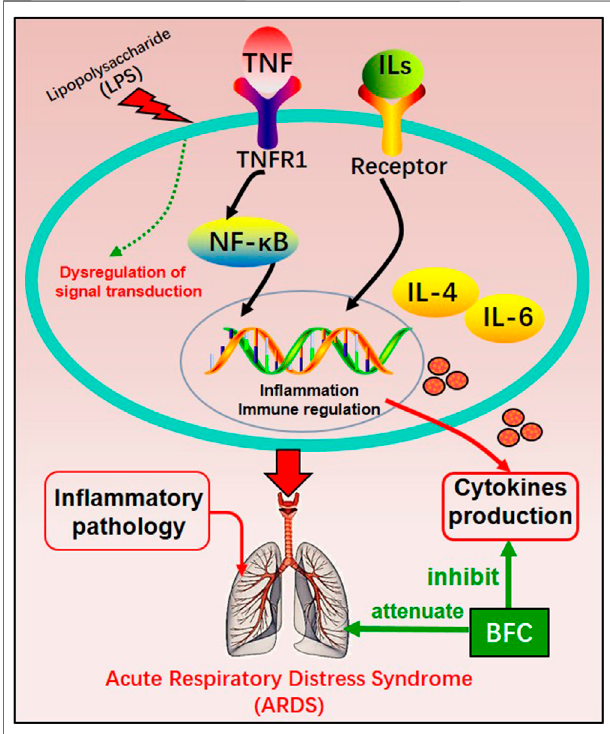
FIGURE 5 | The mechanism of BFC in the treatment of